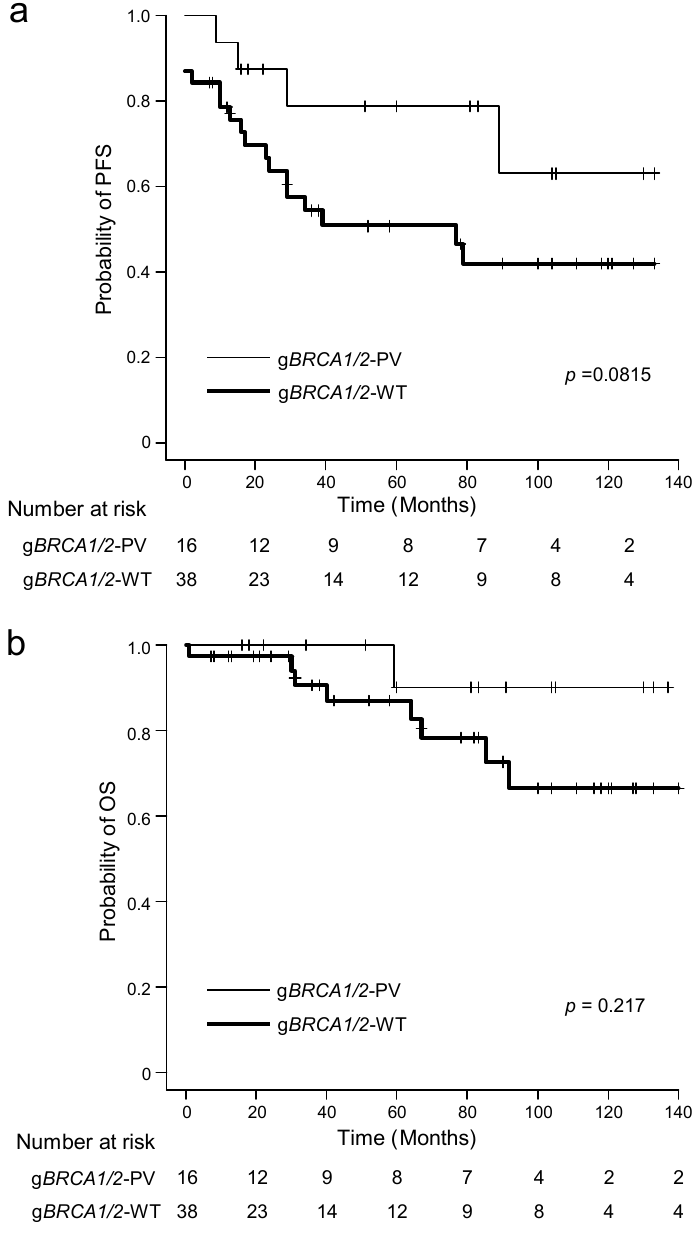
Figure 1. Survival outcomes of 54 participants with advanced-stage ovarian cancer (OC) with g BRCA1/2 pathogenic variants (g BRCA1/2 -PV) and wild type (g BRCA1/2 -WT). ( a ) Progression-free survival (PFS) rate. ( b ) Overall survival (OS) rate.